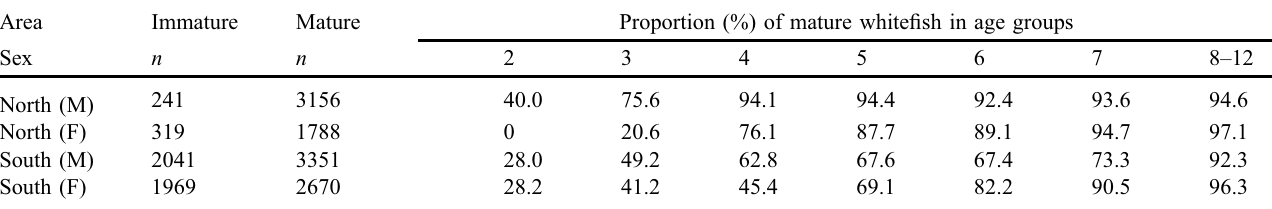
Table 2. The proportion of mature anadromous white fi sh (%; Coregonus lavaretus ) in different sea age groups amongmales (M) and females (F) in the northern and southern Gulf of Bothnia in 1998 – 2014.